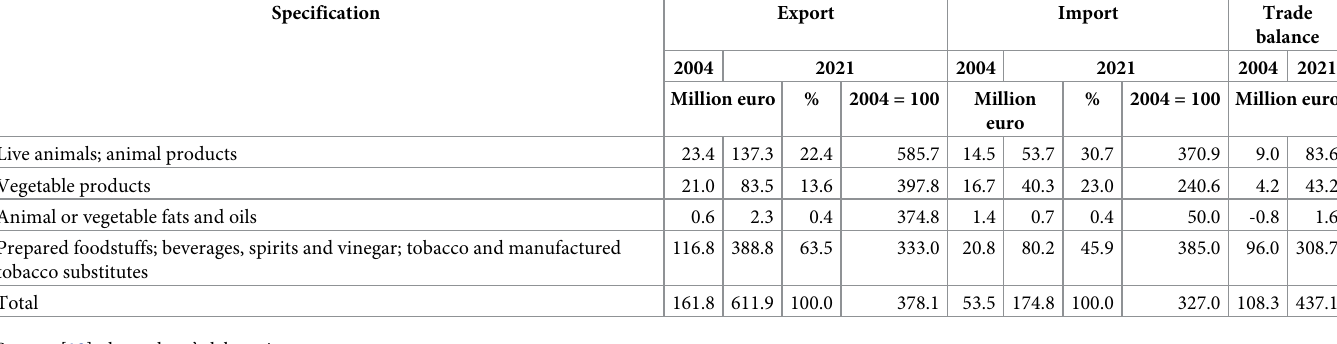
Table 4. Commodity structure of Poland’s foreign trade in agri-food products with the USA in 2004 and